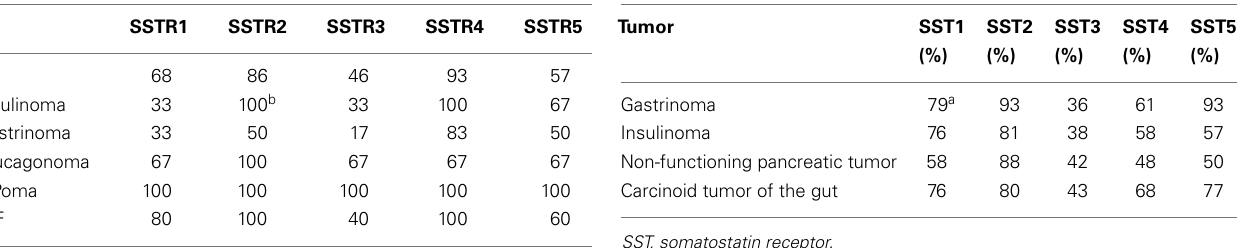
Table 2 | Somatostatin receptor subtypes mRNA in neuroendocrine tumors.